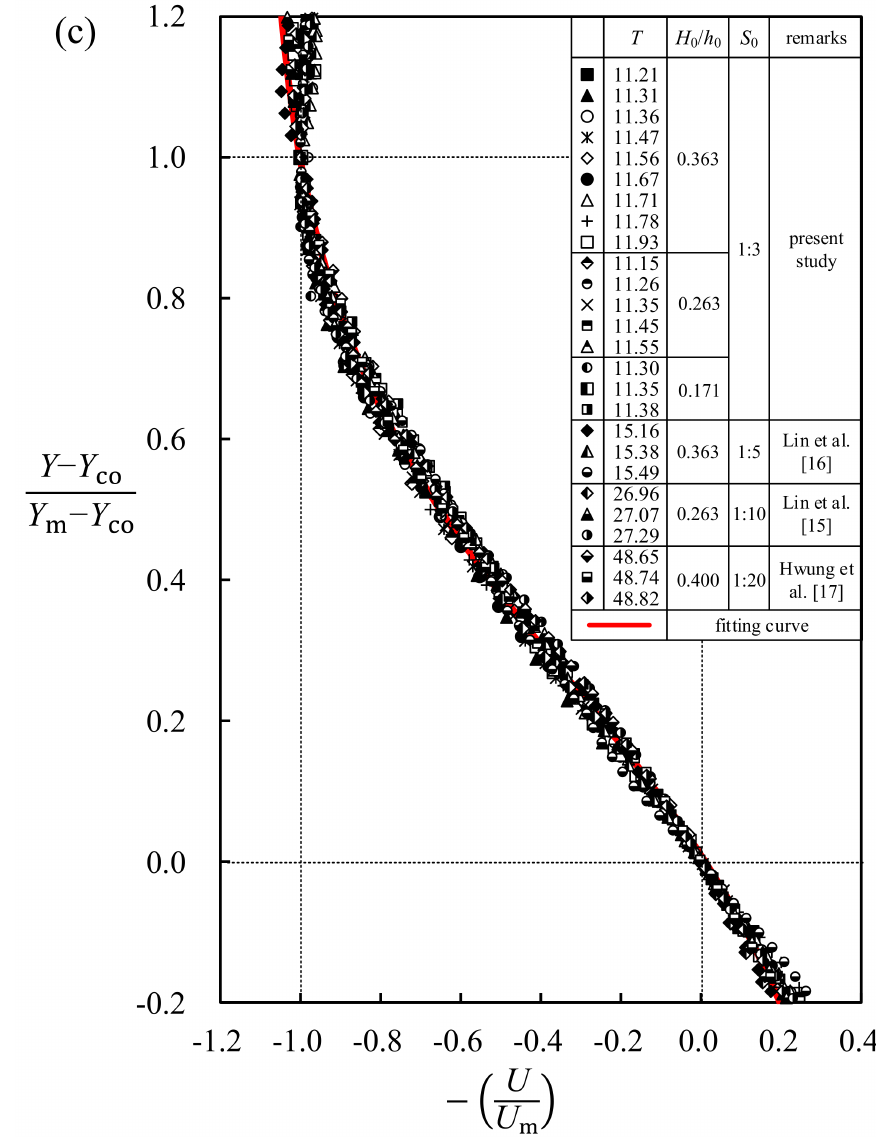
Figure 19. ( a ) Schematic plot of velocity profile U ( Y ) passing through primary vortex core; and ( b ) universal similarity profile of wall jet flow close to beach surface for Y ≤ Y M ; ( c ) universal similarity profile of shear layer flow between Y = Y M and Y = Y m . Note that data from the present three cases for S 0 = 1:3, Lin et al. [15,16] for S 0 = 1:5 and 1:10, and Hwung et al. [17] for S 0 = 1:20 have been included to highlight no effect of H 0 / h 0 and S 0 on these two unique